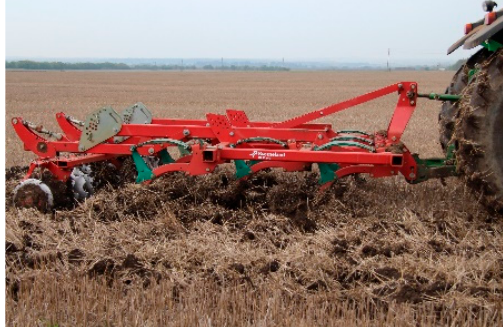
Figure 4. Cultivator at JTEF (Source: Igor Dekemati).